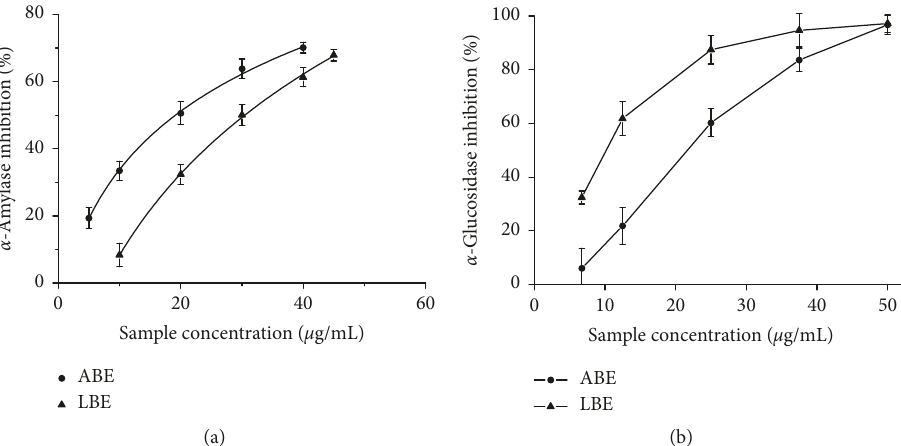
Figure 5: Dose-response curves of α -amylase (a) and α -glucosidase (b) inhibitory activities of ABE and LBE. Data are presented as mean one standard ±